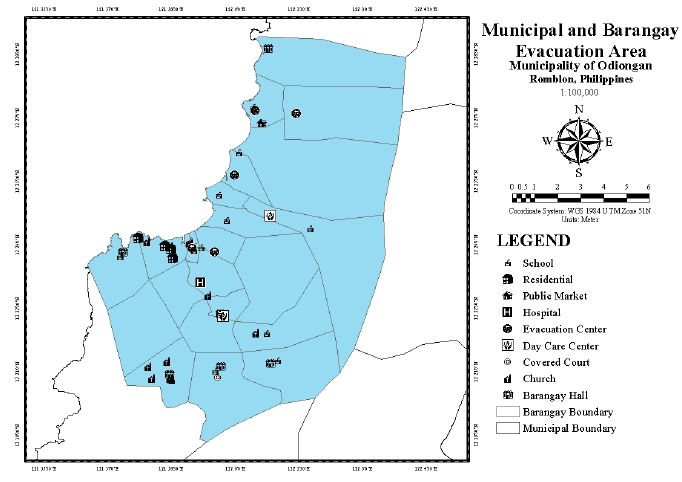
Figure A2. Identified evacuation area of barangay in Odiongan, Romblon, during emergency events.